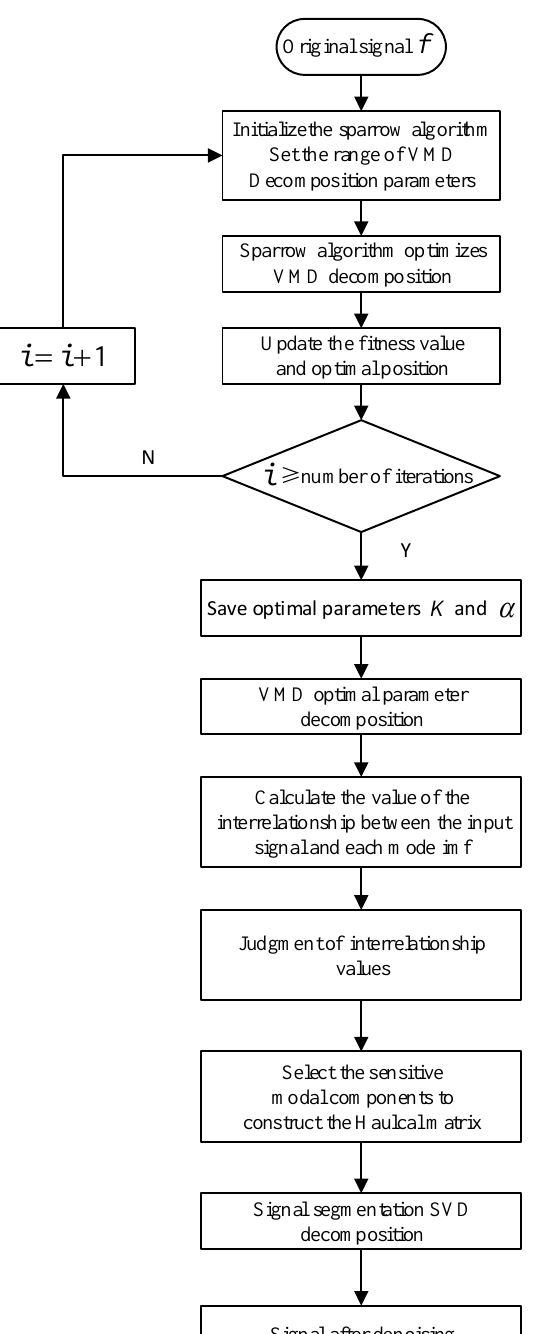
Figure 3. Flow chart of the VMD-SSA-SVD noise-reduction algorithm.